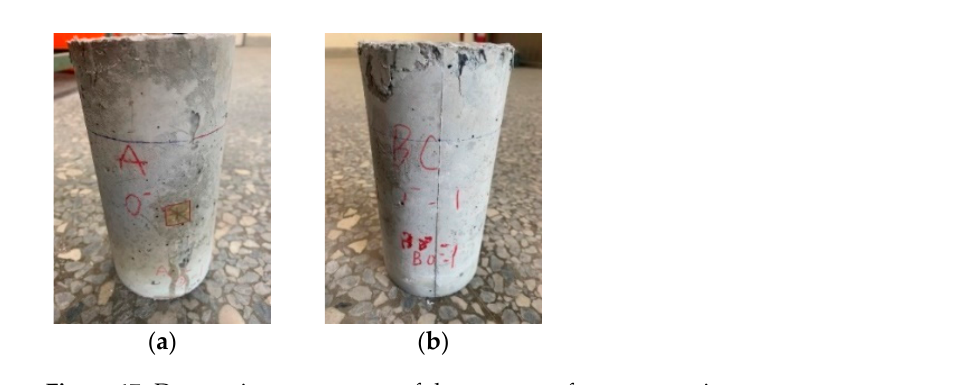
Table 8. Result of secondary compressive test of the compressive failure specimen after self-healing. Concrete Group